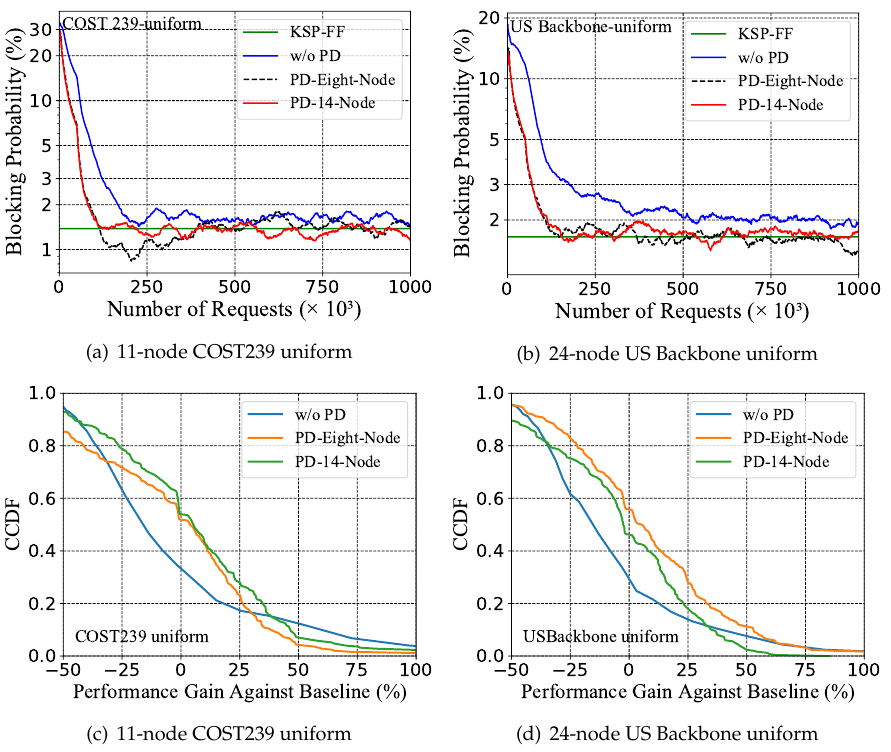
Figure 5. ( a , b ): Blocking probability in training with different topologies, and ( c , d ): complementary cumulative distribution function (CCDF) with blocking reduction compared to KSP-FF algorithm after training with 750,000 traffic